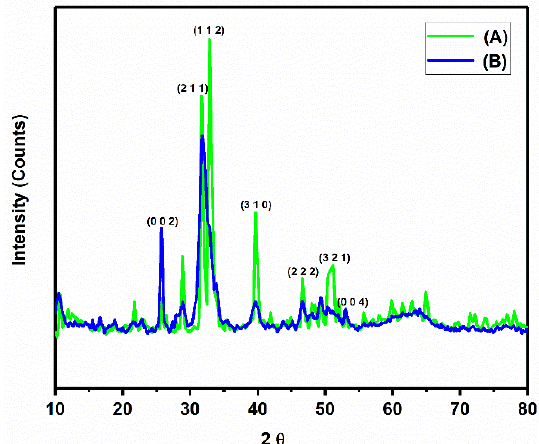
Figure 3. P-XRD patterns of the isolated nano HA, graph (A) thermally calcined nano HA, and graph (B) alkali-treated nano HA.